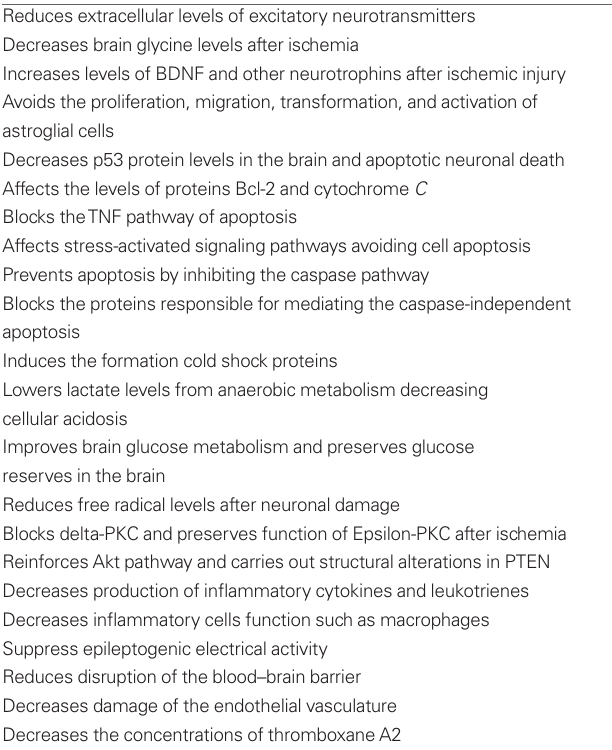
Table 1 | The mechanisms of action of therapeutic hypothermia. Reduces extracellular levels of excitatory neurotransmitters Decreases brain glycine levels after ischemia Increases levels of BDNF and other neurotrophins after ischemic injury Avoids the proliferation, migration, transformation, and activation of astroglial cells Decreases p53 protein levels in the brain and apoptotic neuronal death Affects the levels of proteins Bcl-2 and cytochrome